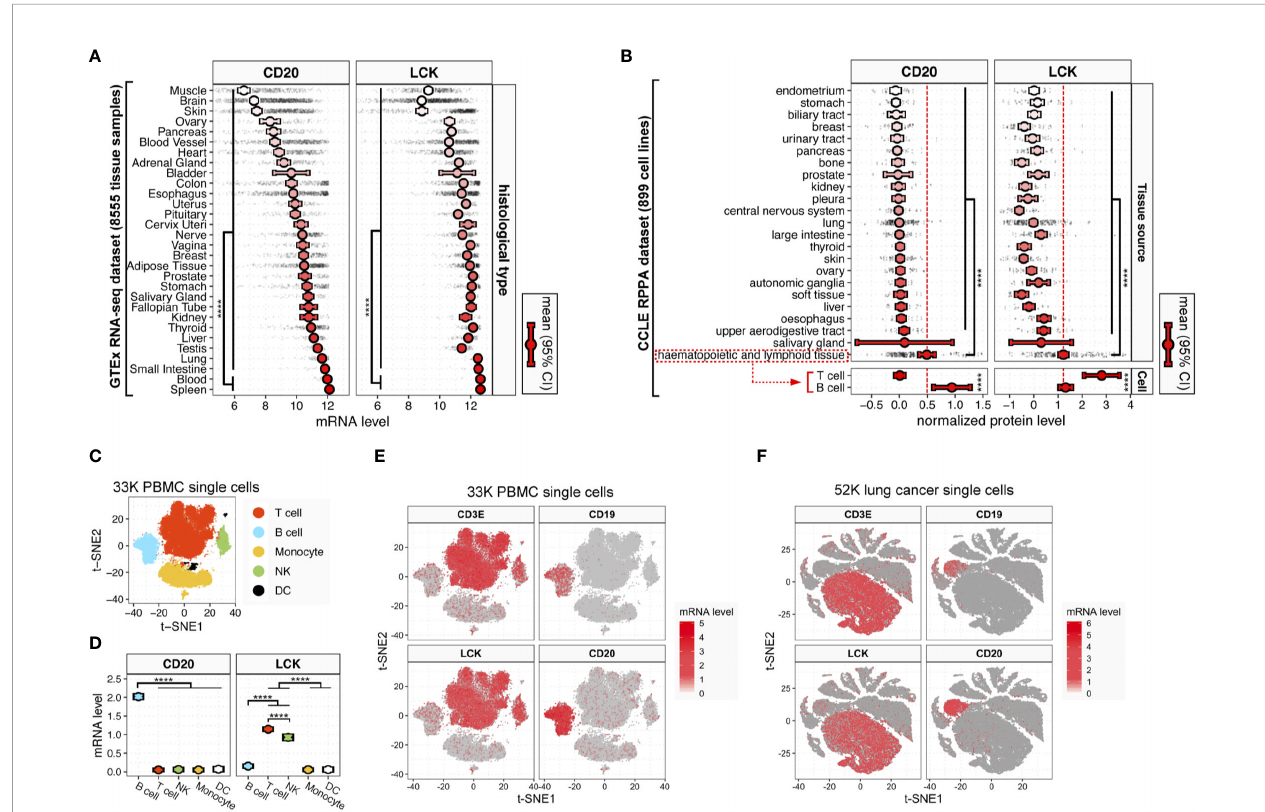
FIGURE 1 | CD20 and LCK expression in different human tissue, cell, and cancer types. (A) CD20 and LCK mRNA expression in human tissues. (B) CD20 and LCK protein expression in human cell lines. Error bars showing mean ± 95% con fi dence interval (CI). The p -value was calculated using ANOVA. (* p